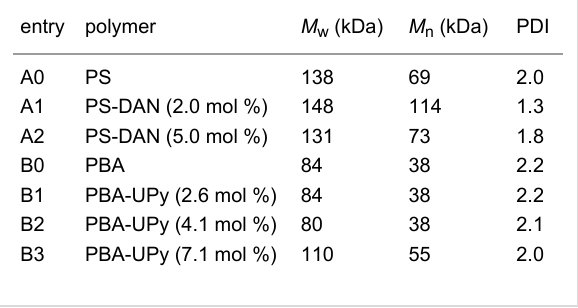
Table 1: Molecular weight, molecular weight distribution and mol % loading of DAN modified PS and UPy modified